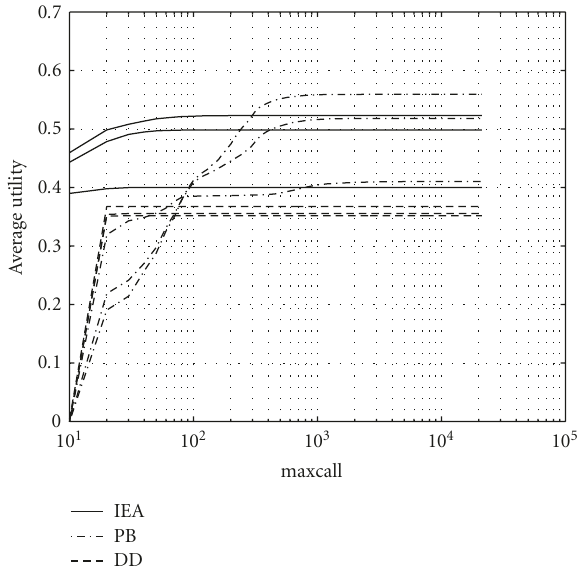
Figure 7: Average utility versus maximum number of WsrMax